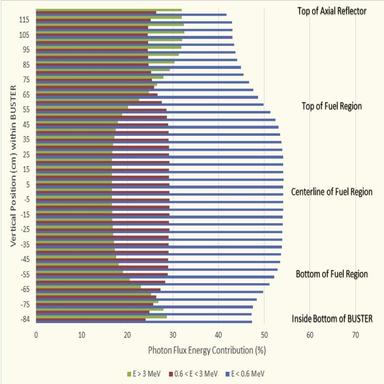
Axial Distribution of Photon Spectra Relative to 1 MeV for Full-Slotted Core (300 K).